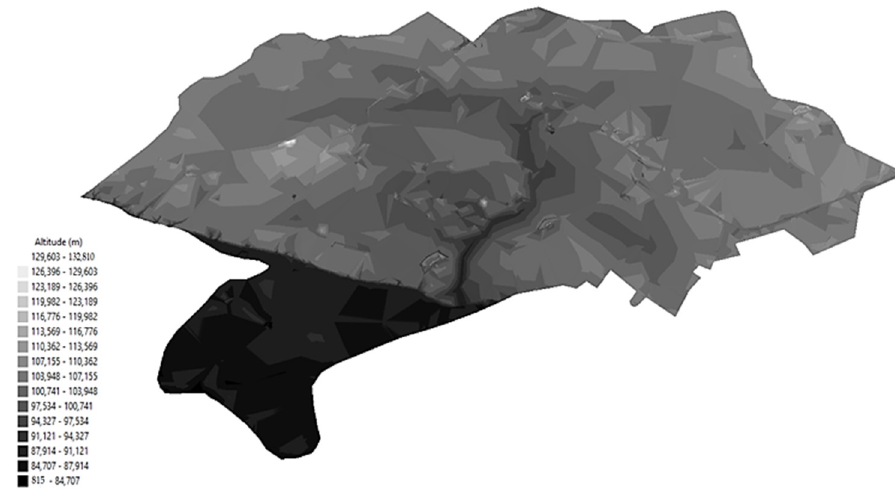
Figure A3. Digital Elevation Model (DEM) for the S ł u ż ewiecki Stream catchment area.